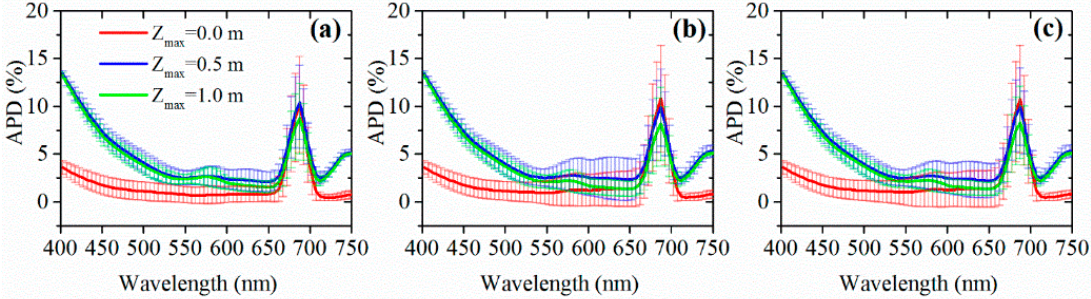
Figure 14. Performance of weighting average functions: ( a ) g Z-KdKLu , ( b ) g GC-KdKLu , and ( c ) g S on Ecolight-simulated data with different maximum depth (Z max ) of Chl a profiles.